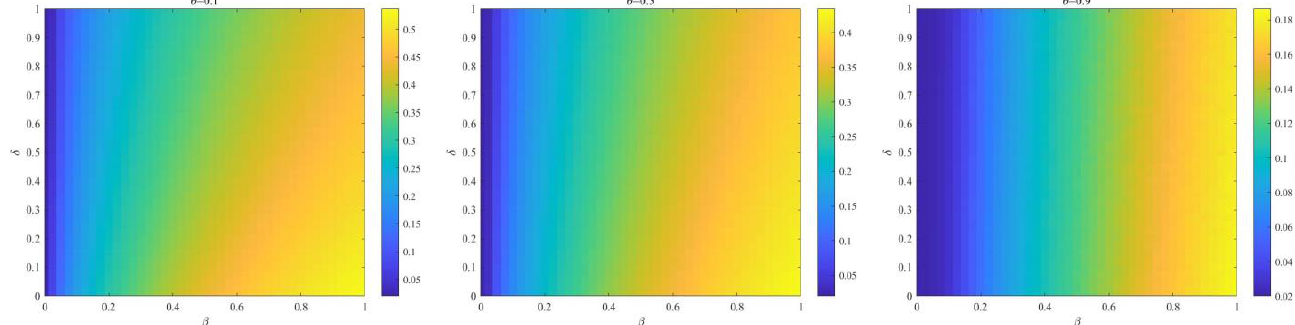
Figure 11. The full-phase diagram δ − β for different values of θ . The color represents the proportion ρ R of recovered enterprise under steady state, other parameters are set as α = 5, m = 2, m 1 = 5, m 2 = 7, κ = 2, η = 0.8, µ = 0.8, λ = 0.8, γ = 0, p = 0.5, q = 0.5.